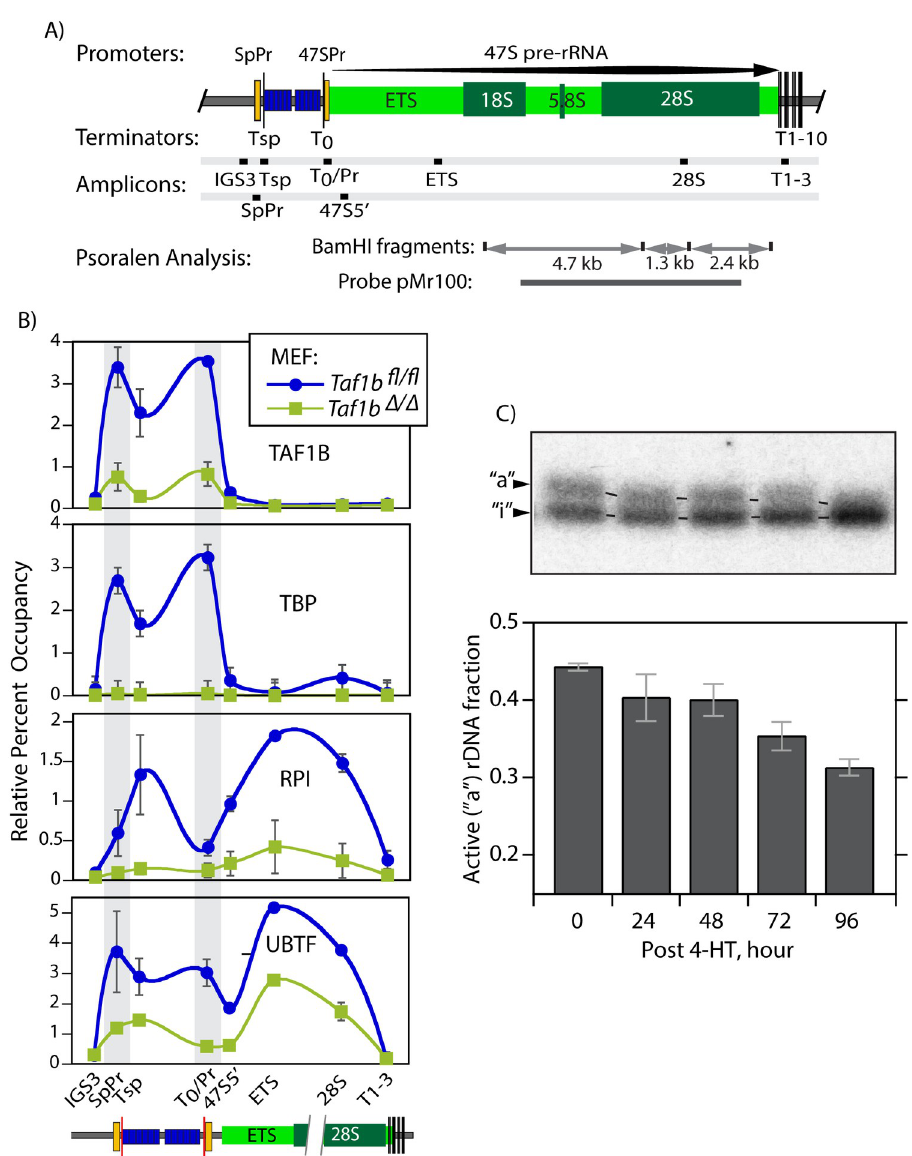
Fig 2. Loss of TAF1B abrogates RPI but not UBTF recruitment to the rDNA. A) Organisation of the mouse rDNA locus indicating the positions of the Spacer (SpPr) and 47S (47SPr) promoter sequences, the RPI termination sites Tsp, T 0 and T1-10, the extent 47S pre-rRNA coding region (light green) and the encoded 18, 5.8 and 28S rRNAs. The positions of the qPCR amplicons used in ChIP analyses are indicated, as are the rDNA fragments and pMr100 probe used in psoralen accessibility cross linking (PAC). B) ChIP-qPCR analysis of TAF1B, TBP, RPI and UBTF occupancy at sites across the rDNA of Taf1b fl/fl /p53 -/- /ERcre +/+ MEFs before and 5 days after Taf1b inactivation by 4-HT treatment. The data derive from 3 biological ChIP replicas each analyzed by qPCR in triplicate. S5 Fig shows a similar ChIP analysis in Taf1b fl/fl /ERcre +/+ mESCs with mapping of TAF1B, TAF1C and TBP subunits of SL1. C) PAC reveals a gradual reduction in the amount and mobility of active rDNA chromatin following Taf1b inactivation as in B. Upper panel shows a typical psoralen time course analysis of rDNA chromatin showing the lower mobility of the active “a” and higher mobility of the inactive “i” 1.3kbp BamHI-BamHI fragment from the rDNA 47S coding region. The lower histogram panel shows the mean active rDNA fraction estimated from curve fit analysis of the 1.3, 2.4 and 4.7kbp BamHI-BamHI rDNA fragment profiles in two biological replicas. Error bars indicate the SEM.